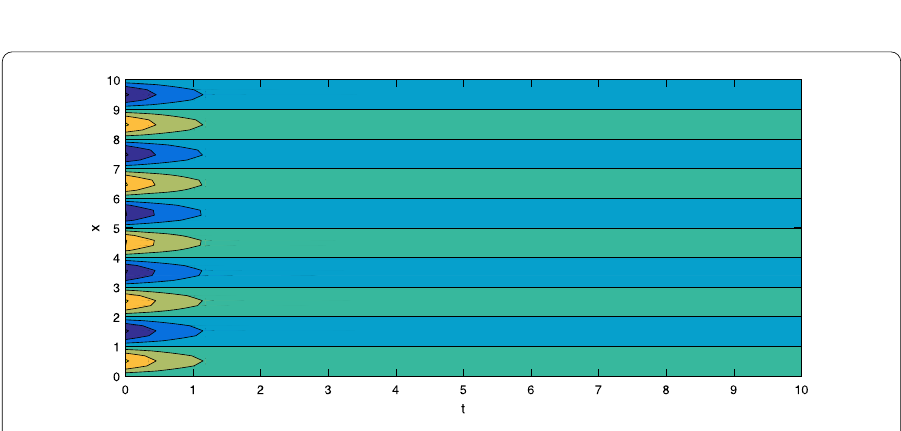
Figure 5 The contour solution plot given by (47) of fractional heat equation (1) for different values of α = 0.4,0.6,0.8,1.0 and fixed values of the variables z = y = 0.5 in the tx